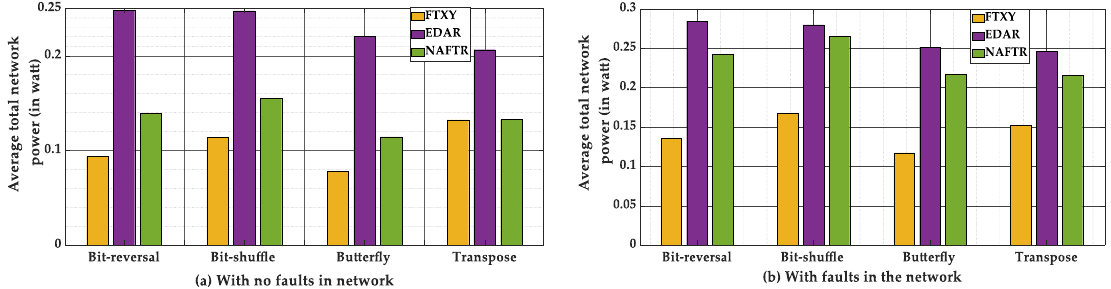
Figure 9. Total network average power consumed under faultless and faulty network scenarios.